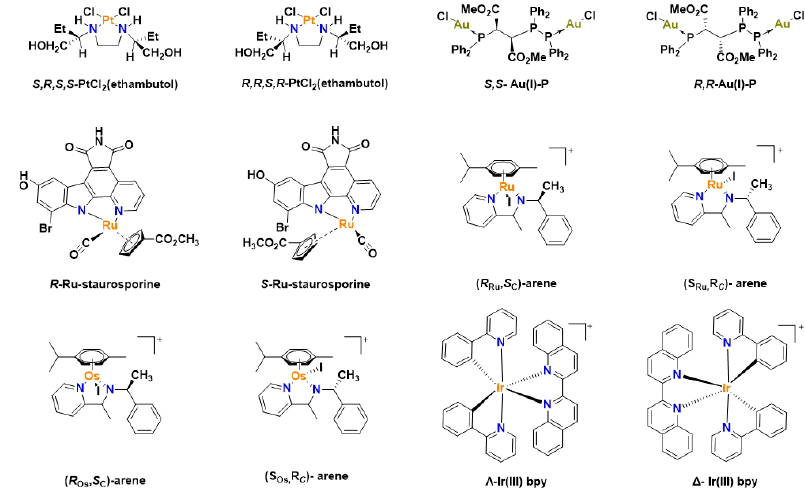
Figure 1. Chiral organometallic complexes with anticancer properties.